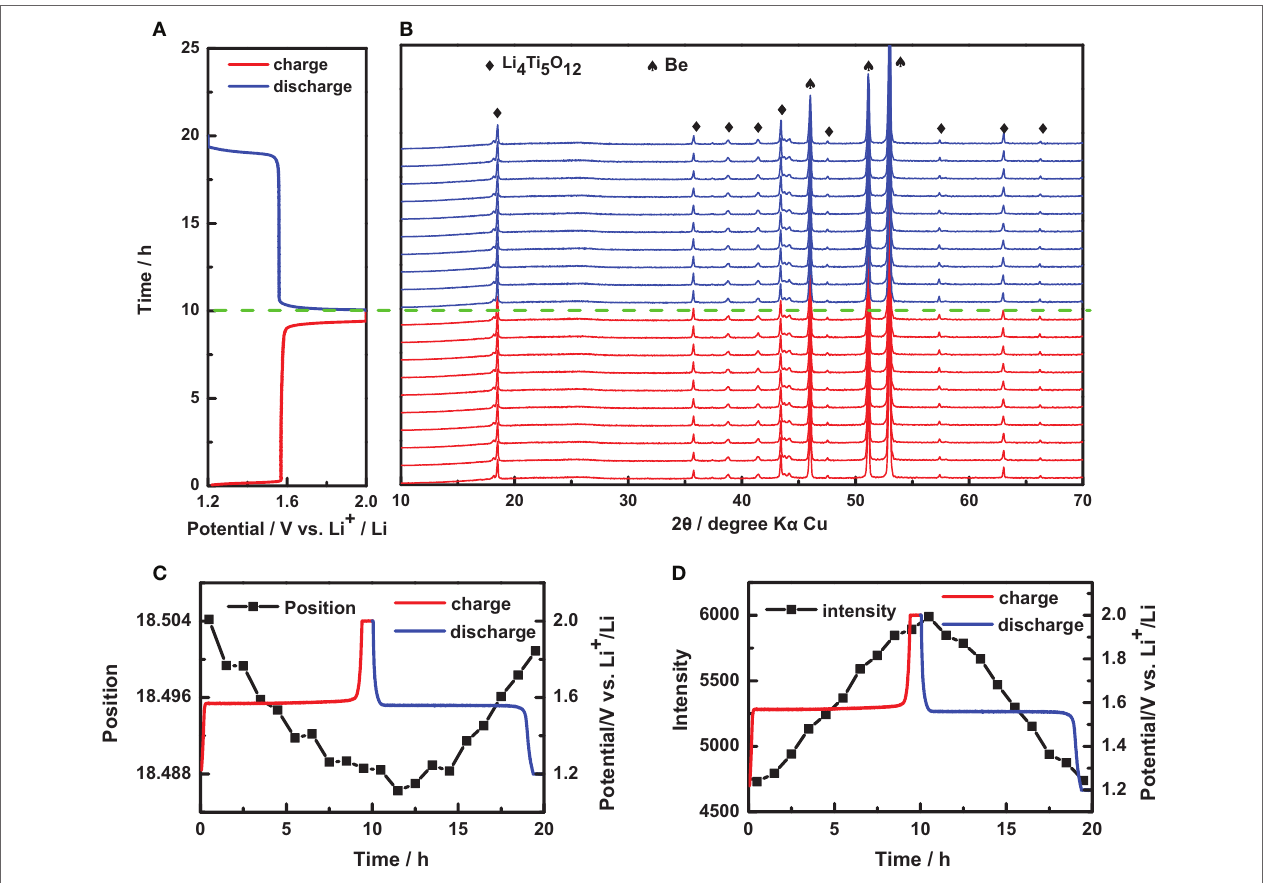
FigUre 5 | In situ characterization of Li 4 Ti 5 O 12 electrode. (a) A charge/discharge curve of an in situ coin cell with Li 4 Ti 5 O 12 electrode: charge at C/10 to 2.0 V and then potentiostatic within 10 h; discharge at C/10 to 1.2 V and then potentiostatic within 10 h. (B) In situ X-ray diffraction (XRD) patterns of this in situ coin cell during the charge and discharge processes. The variation of (c) position and (D) intensity of peak (111) retrieved from in situ XRD patterns in (B) .